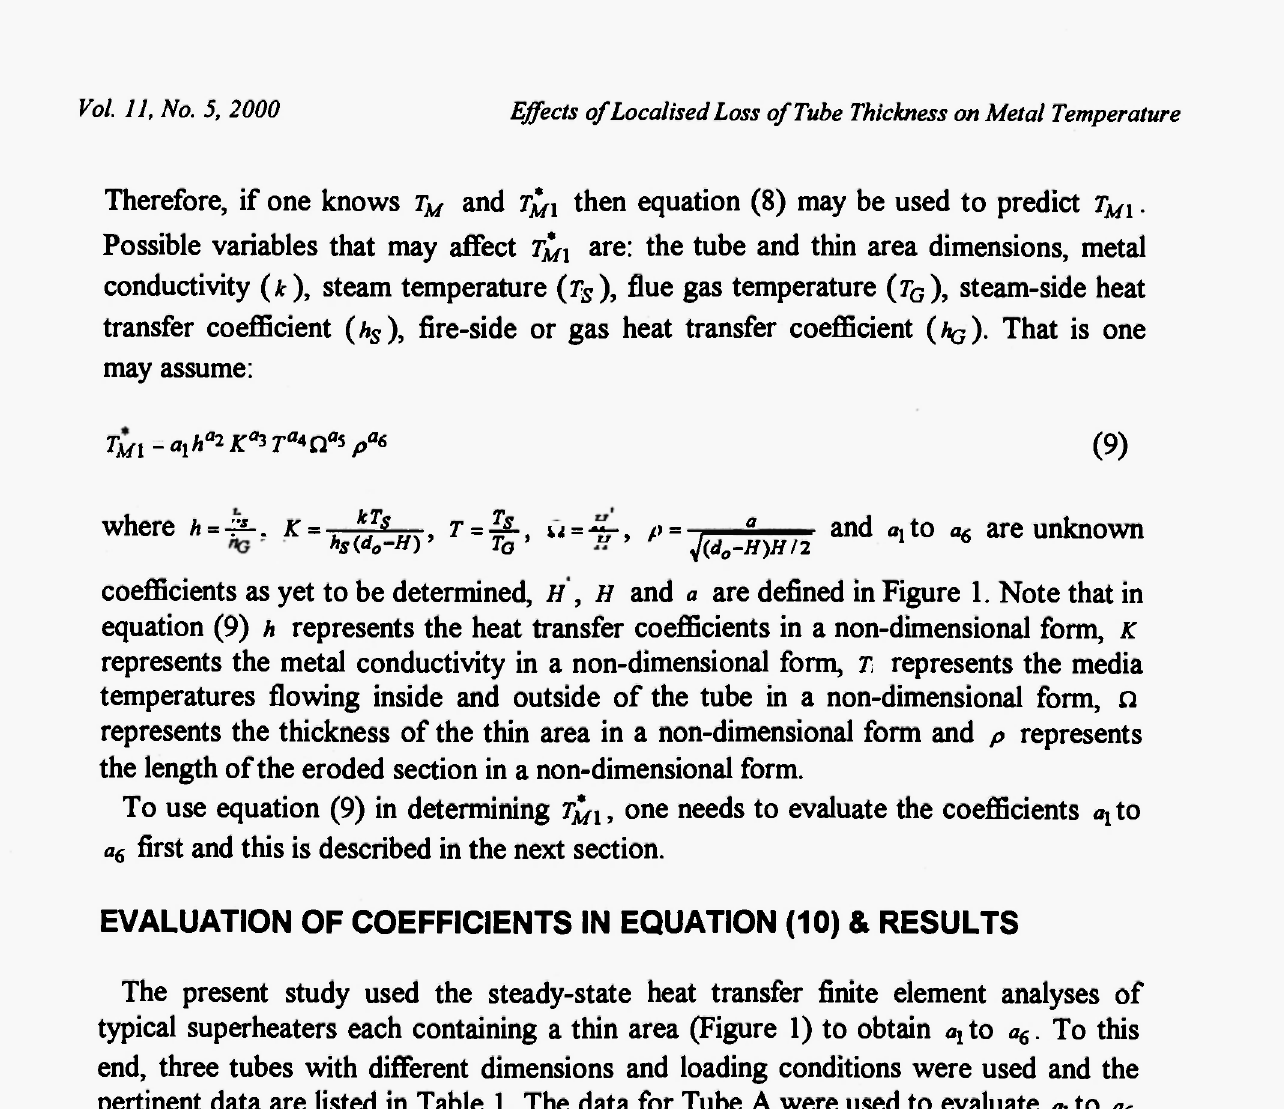
Table 1 - Tube data used in the heat transfer